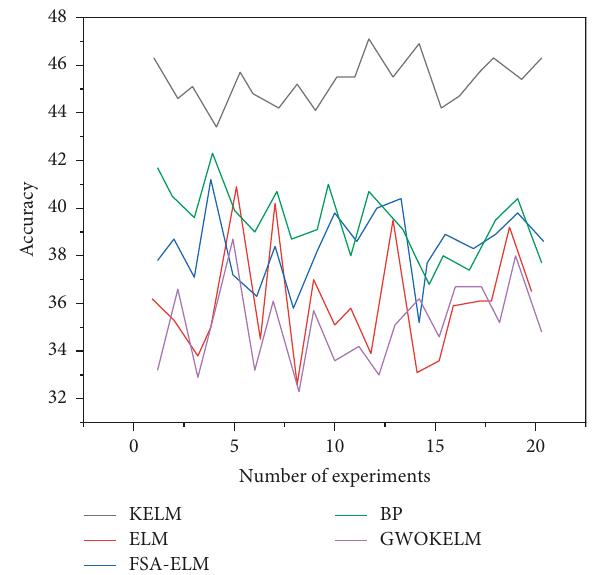
Figure 5: The results of fault